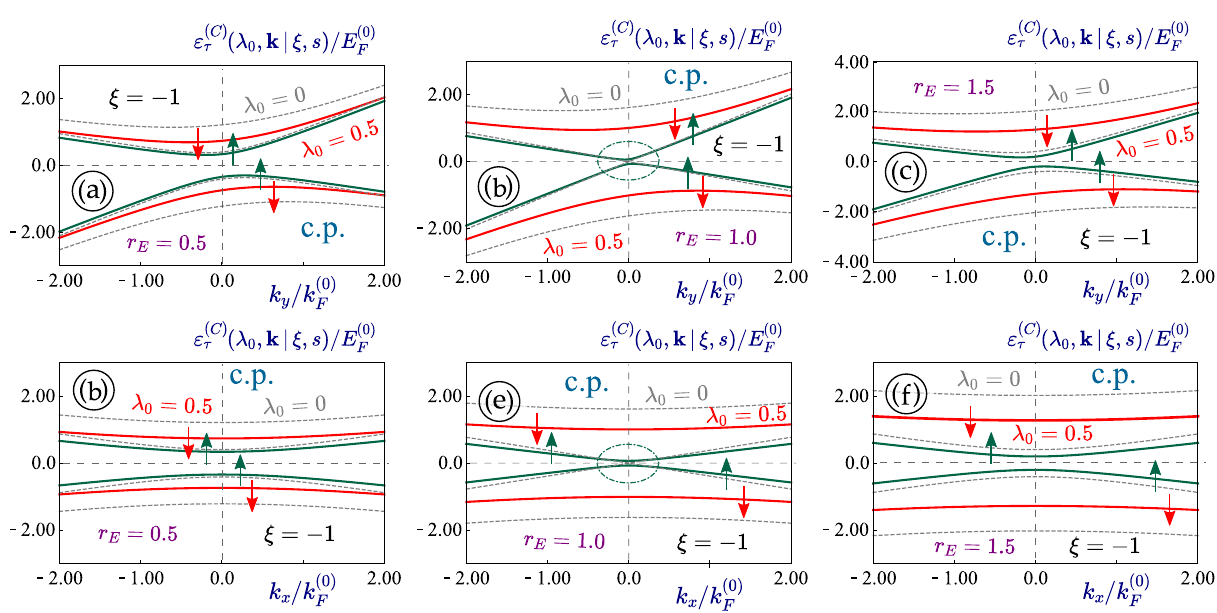
( C ) (cid:31) k 1, s ) for the case of a circularly-polarized ξ Figure 8. (Color online) Energy dispersions ε 0 , 1 ( τ | = − 0 ) and the same =± irradiation applied to a 1T ′ -MoS 2 lattice. The dispersions for non-irradiated materials ( (cid:31) 0 = lattice parameters are also presented as dashed and gray curves for comparison. Upward and downward spin 1 are indicated by green and red arrows, respectively. Panels ( a )-( c ) show the 1 and s states with s = − = + initially asymmetric k y -dependence of electron band structure, while the lower panels ( d )-( f ) demonstrate their k x -dependence. As seen, each two panels are connected to each other by a selected value for external 0.5 [( a ), ( d )], 1.0 [semi-metallic; ( b ), ( e )] and 1.5 [( c ) and ( f )]. Here, K electrostatic field r E ′ -valley with = 1 was selected for all ξ = −